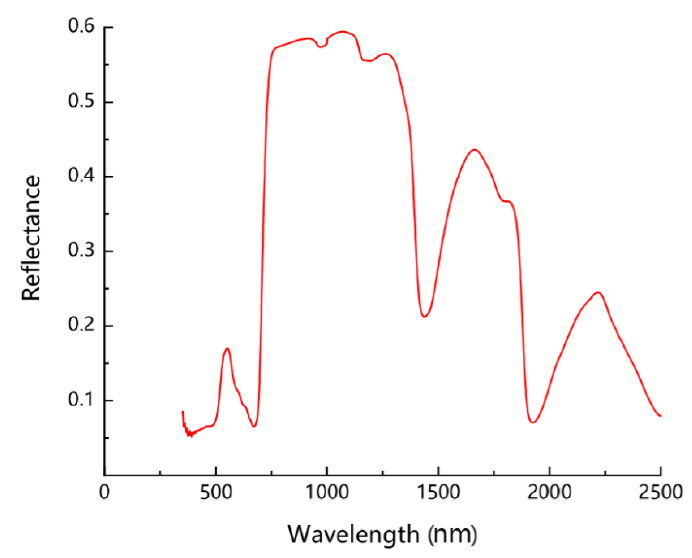
Figure 2. Spectral reflectance curve of peanut canopy leaves.